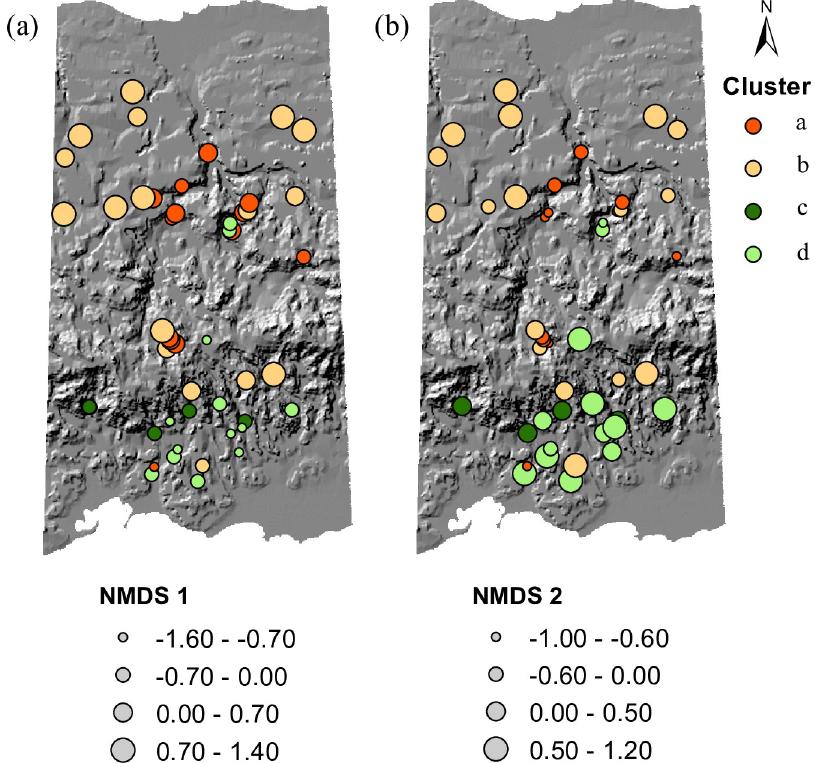
Fig 5. Spatial distribution of NMDS scores for the (a) first and (b) second NMDS ordination axes. The colors show each vine patch grouped by cluster according to the hierarchical cluster